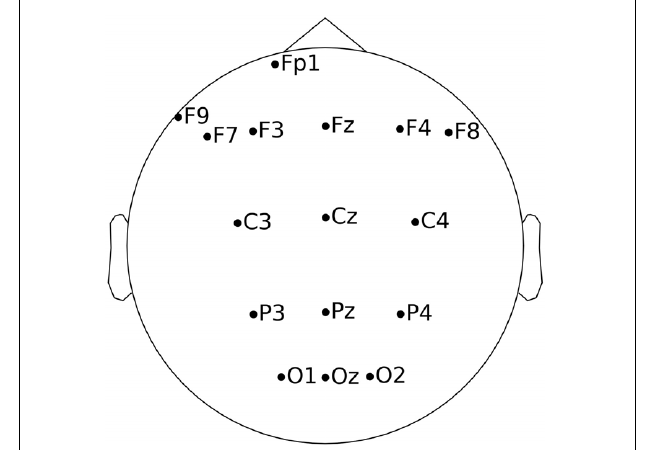
FIGURE 2 | Electrodes and their location on the